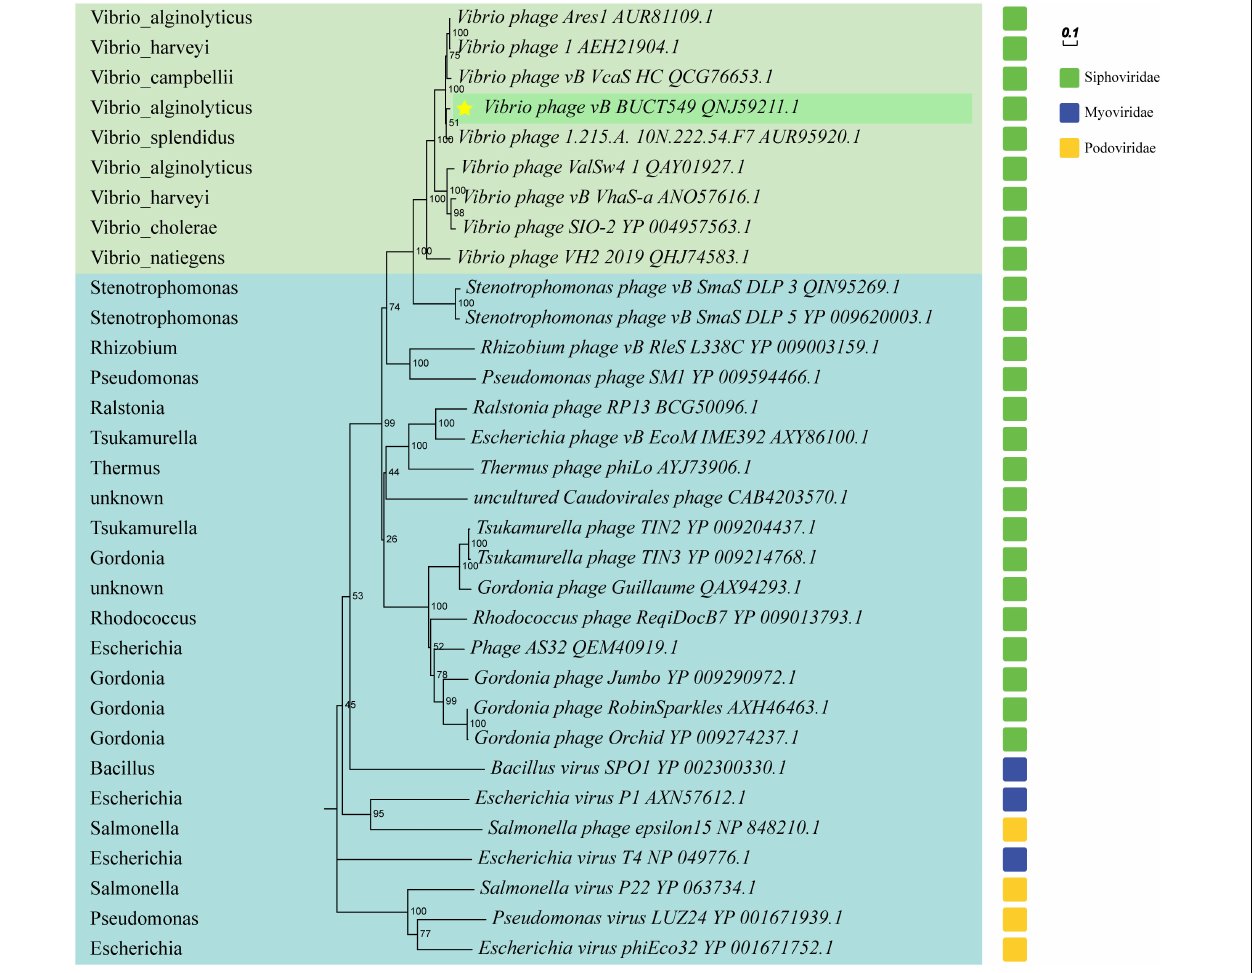
Frontiers in Microbiology |